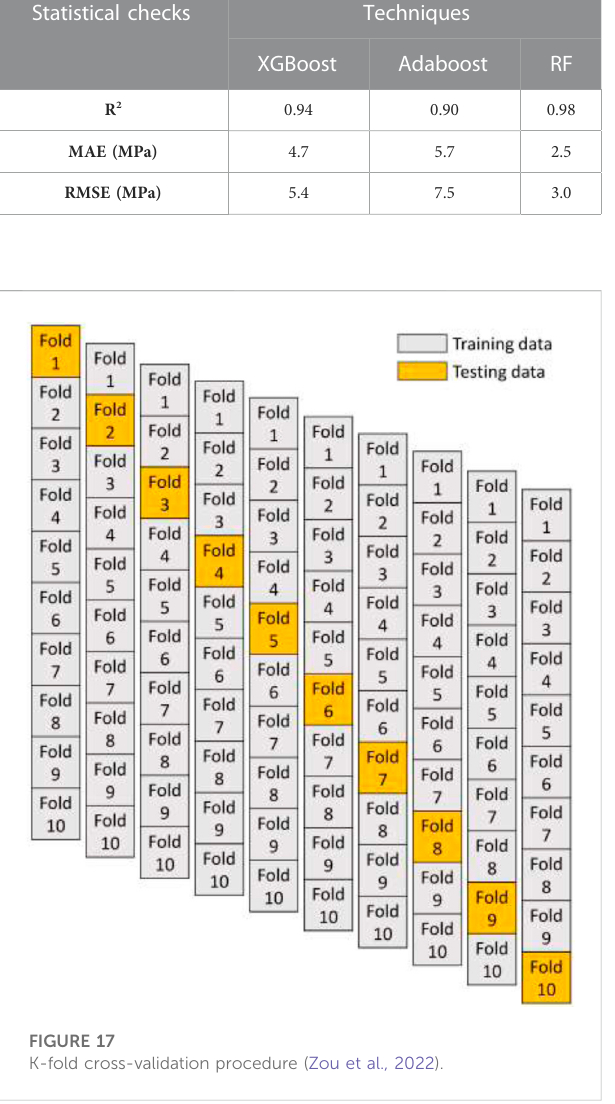
FIGURE 17 K-fold cross-validation procedure (Zou et al., 2022).